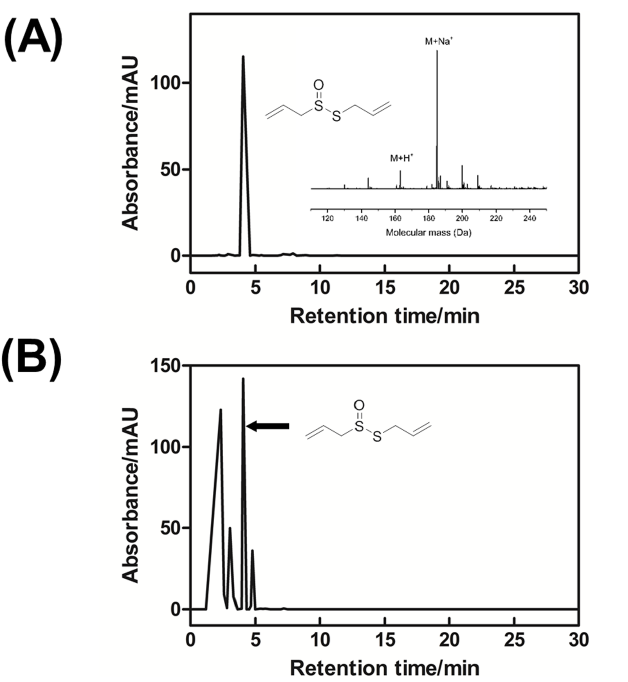
Figure 2. HPLC and MS analysis of aqueous allicin standard (AAS) and aqueous garlic extract (AGE). (A) AAS was analysed using a C18 reverse phase column with UV detection at 240 nm. The standard eluted at 4.1 minutes. AAS had an observed m/z of 185.0067 (consistent with the [M + Na] + species; theoretical m/z 185.0065;